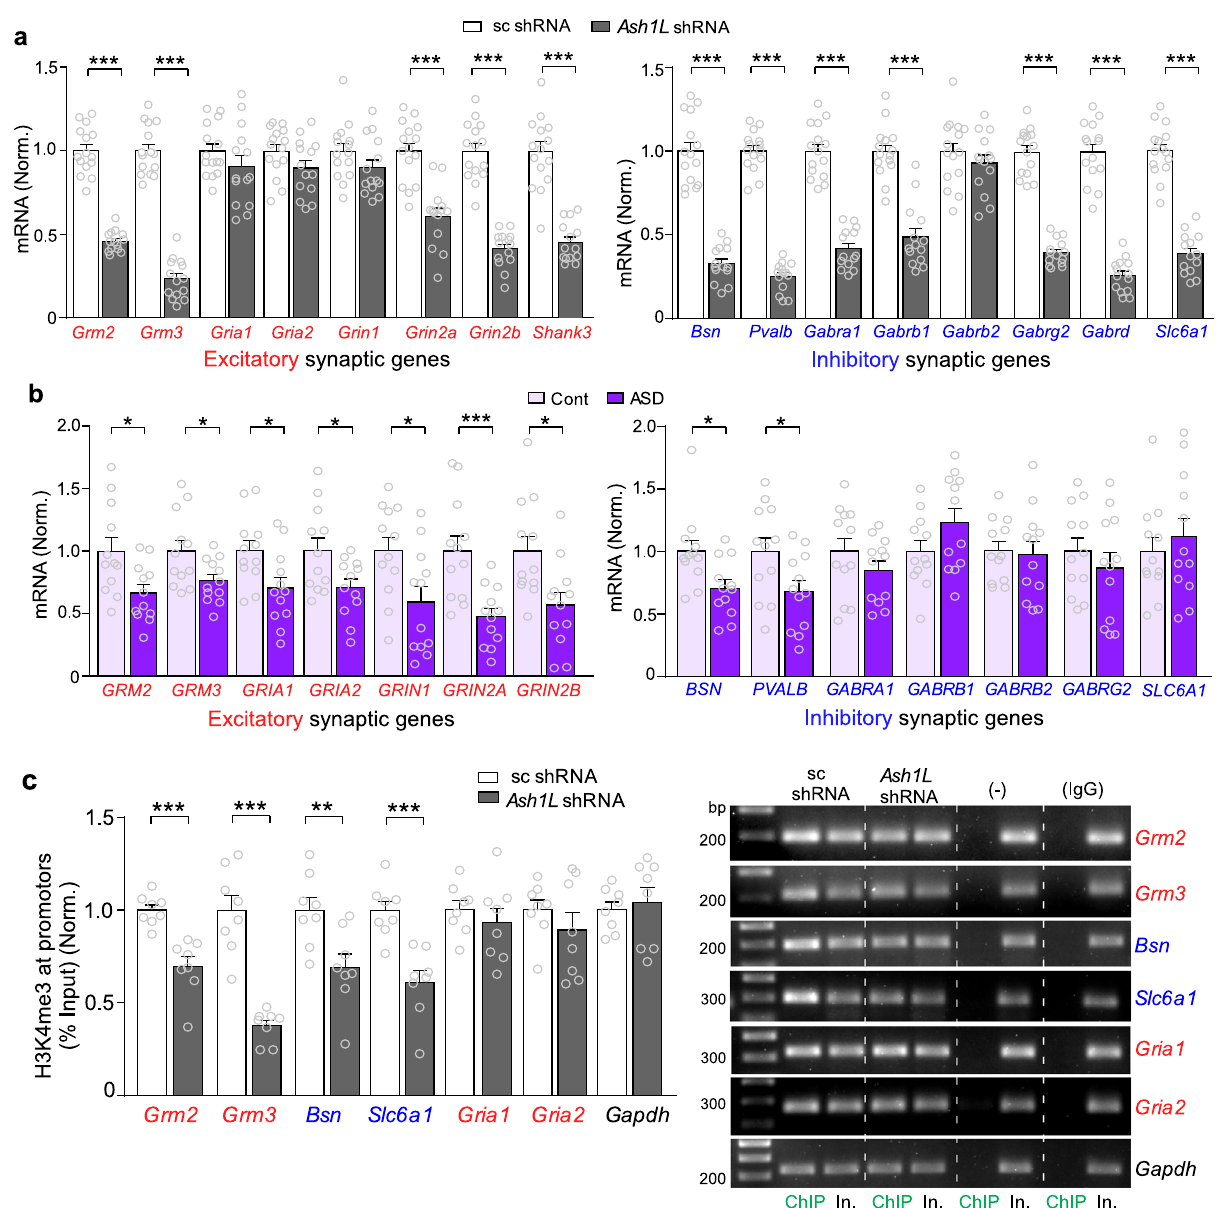
Fig. 3 The transcriptional loss of synaptic genes by Ash1L de fi ciency are correlated with the reduced H3K4me3 enrichment at their promoters. a , b Quantitative real-time PCR showing the mRNA level of excitatory and inhibitory synaptic genes in PFC of mice infected with Ash1L shRNA vs. scrambled shRNA ( a ) or postmortem PFC tissues from ASD patients vs. control subjects ( b ). A, n = 14 – 15 mice (7 – 8 M,7 F)/group; B, n = 12 humans(10 M,2 F)/ group, * p < 0.05, two-tailed t test. c ChIP assay showing the enrichment of H3K4me3 at the promoter region of Grm2 , Grm3 , Bsn, Slc6a1 , and Gapdh in PFC of mice infected with Ash1L shRNA vs. scrambled shRNA AAV. n = 8 mice(4 M,4 F)/group. Inset: PCR images of the ChIP data. Rabbit IgG and omission of H3K4me3 antibody were used as the negative control. In.: input. All the full PCR gels are included in Supplementary Fig. 7d. Data are presented as mean values ± SEM. Detailed statistical data are provided in a Source Data fi